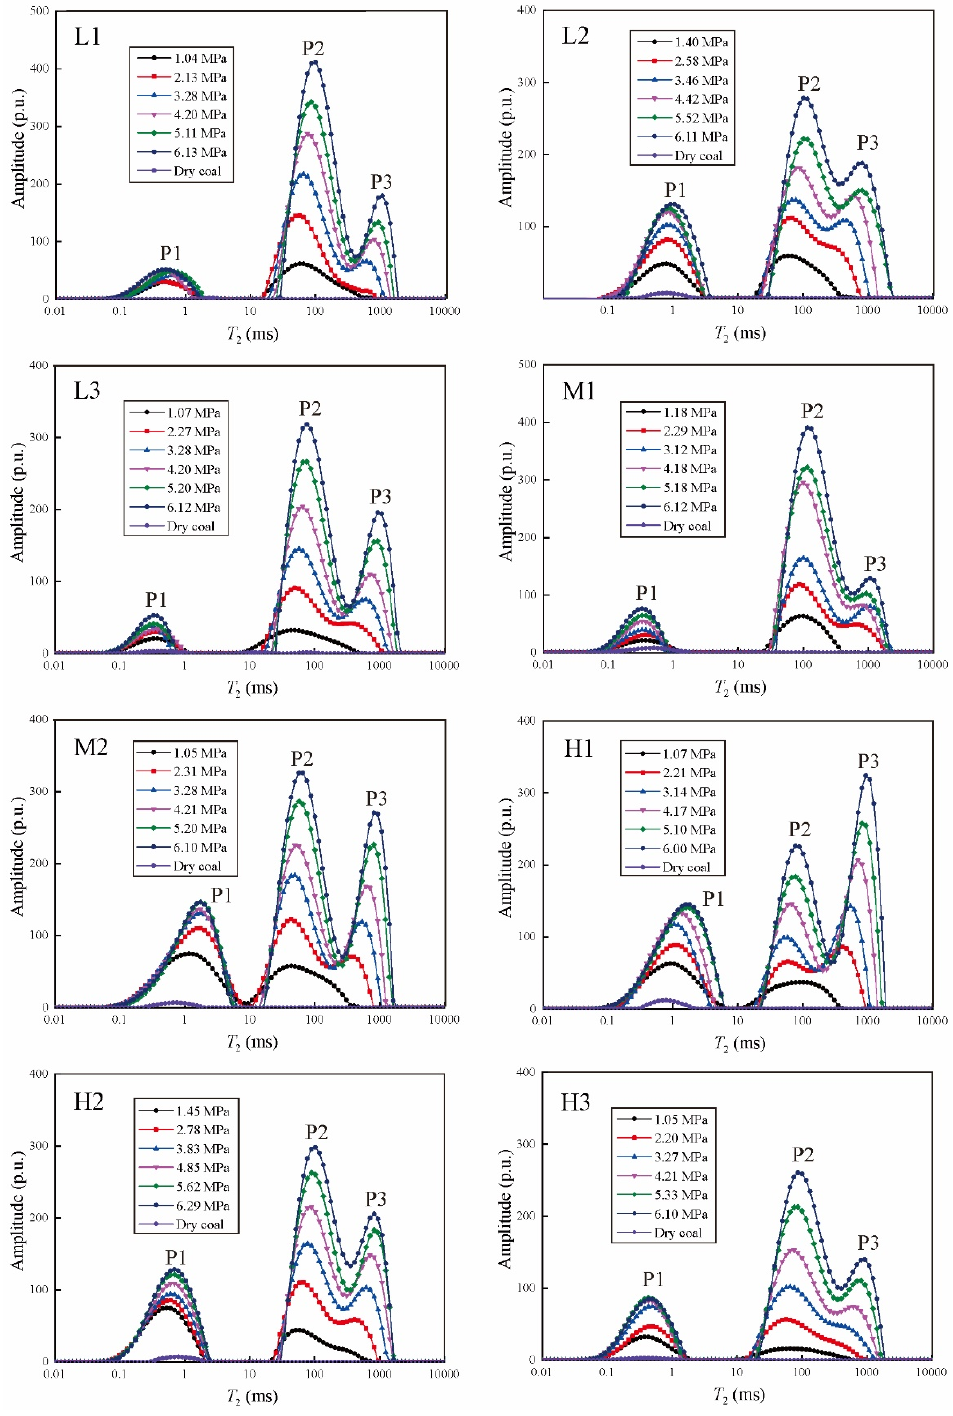
Figure 5. NMR T 2 spectra of methane adsorption in coals.